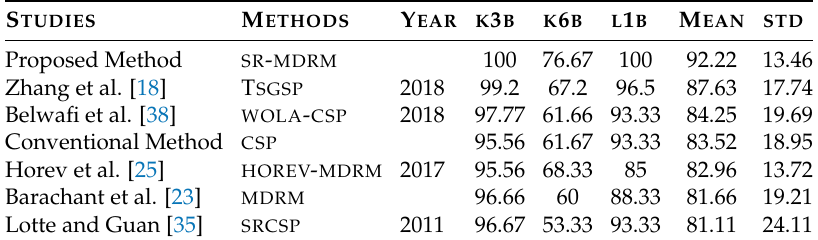
Table 5. Classification accuracy (Mean and Standard deviation in percent)of the proposed approach and other MI classification approaches on Dataset IIIa, BCI Competition